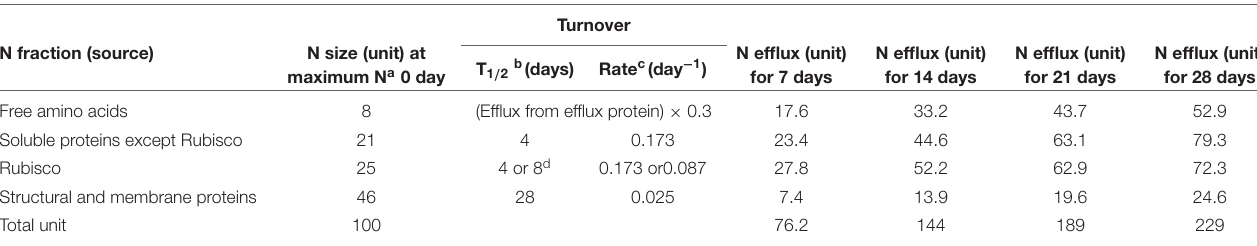
FIGURE 6 | (A) Four-compartment model including four different types of N pools (C), quantities of labeled N (q) and transfer rates (R) between compartments in mature rice leaves. (B) Simulated partitions of labeled N in different pools in the middle leaves of rice. Adapted from Yoneyama and Takeba (1984). TABLE 2 | Temporal changes of N efflux from a mature leaf involving protein turnover in leaf N